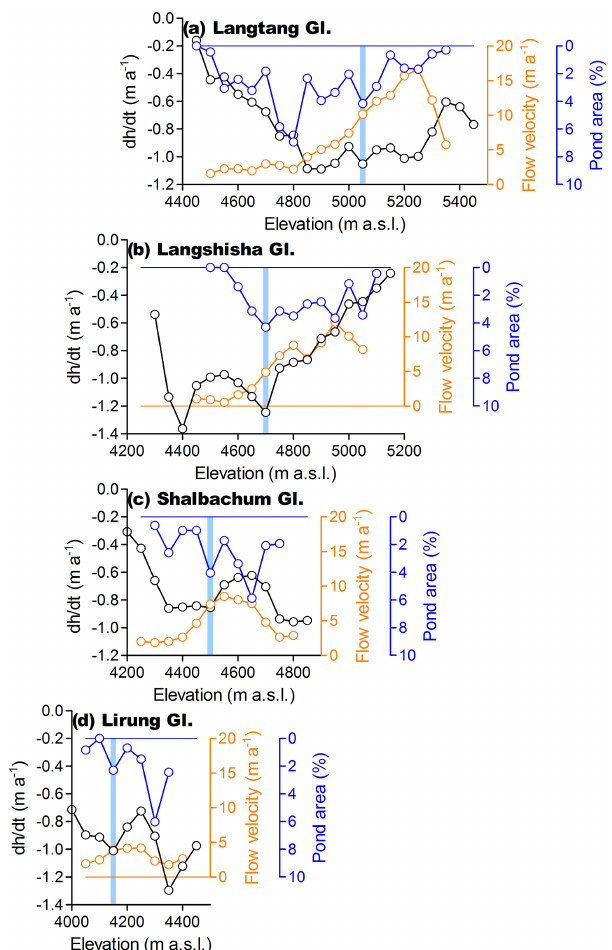
Figure 7. Elevation profiles of the rate of elevation change (d h/ d t , black), ice-flow velocity (orange), and supraglacial pond area (blue) versus elevation (in 50m elevation bands) for the debris-covered area of four glaciers in the Langtang region, Nepal Himalaya, mod- ified from Ragettli et al. (2016). The light blue bars in each panel denote peaks in the supraglacial pond area fraction that are men- tioned in the main